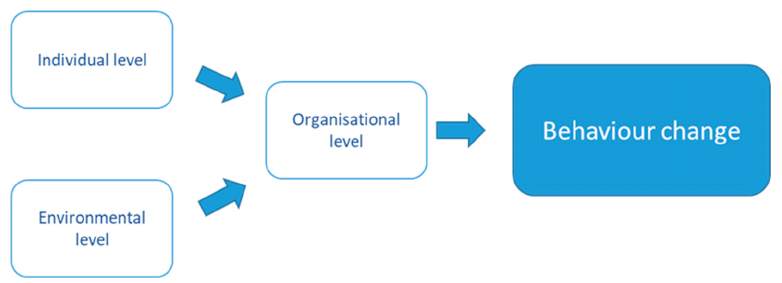
Figure 1. Conceptualisation of mediators of behaviour change in workplace ‐ based research.